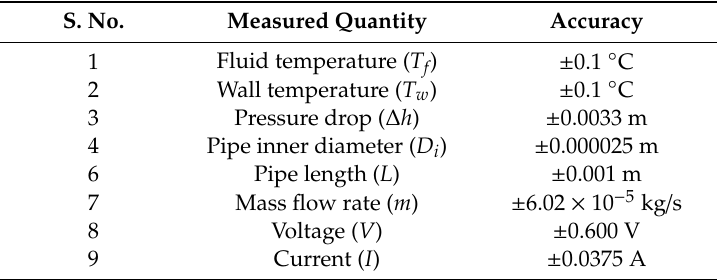
Table 3. The uncertainty of the measuring instruments. S.